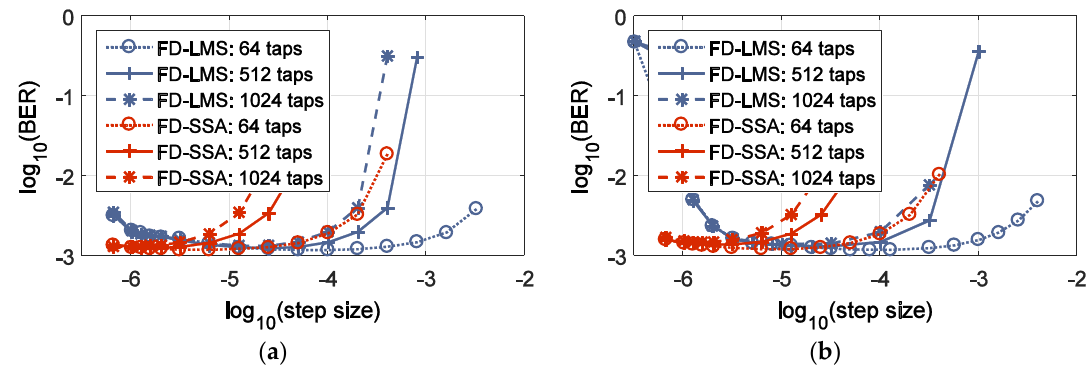
Figure 5. Step size optimization of different multiple-input multiple-output (MIMO) algorithms. ( a ) step-size dependence of achievable bit-error rate (BER) for FD 2 × 2 least mean square (LMS) and Stokes Space Algorithm (SSA); and ( b ) for FD 6 × 6 LMS and SSA. Optical signal-to-noise ratios (OSNR) = 14 dB. Table 1 sums up the optimum step-sizes for FD-SSA and FD-LMS for the 2 × 2 and 6 × 6 case. Table 1. Step sizes used for the different equalizers considered.